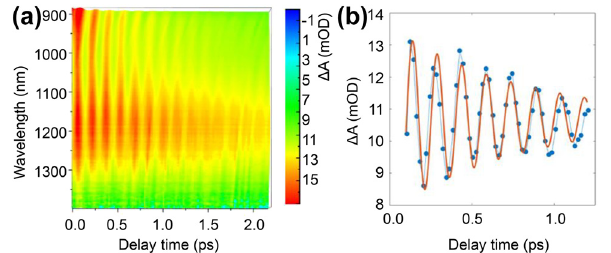
Figure 6: Coherent oscillation of breathing mode in IR band. (a) TA spectra for the infrared plasmons at the probe wavelength 900 – 1350 nm for MXene fi lm, the wave-like oscillation appears for the full probe band. (b) Dynamics at the probe wavelength of 1130 nm (dot line), where periodical oscillation appears. The red curve shows the fi tting result by damping sine